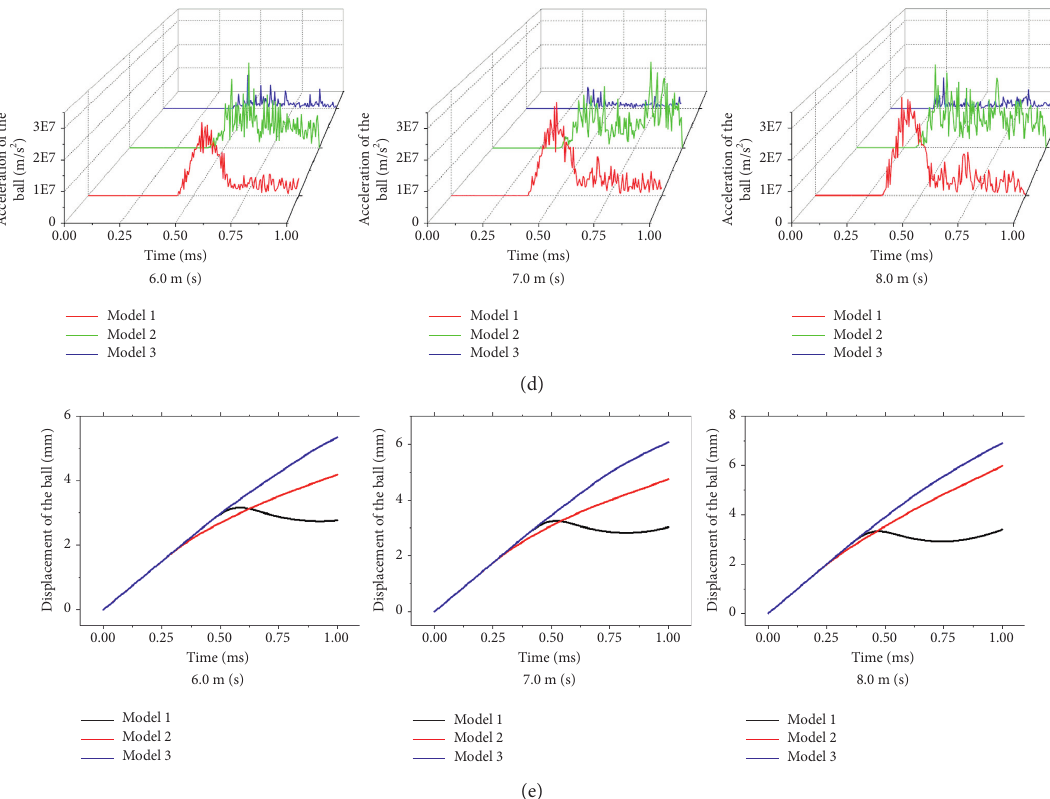
Figure 15: Simulation data. (a) Acceleration of the tail beam. (b) Displacement of the tail beam. (c) Particle velocity. (d) Particle ac- celeration. (e) Particle displacement.